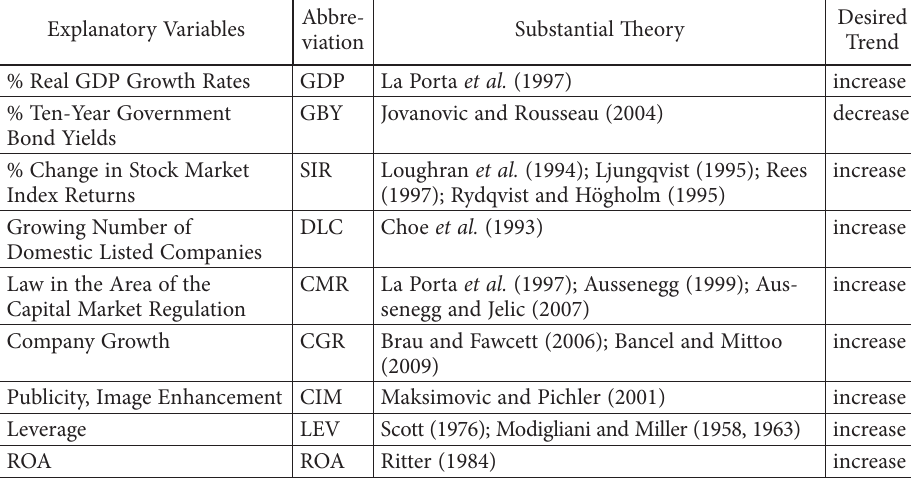
Table 1. Set of variables influencing IPO timing Explanatory Variables